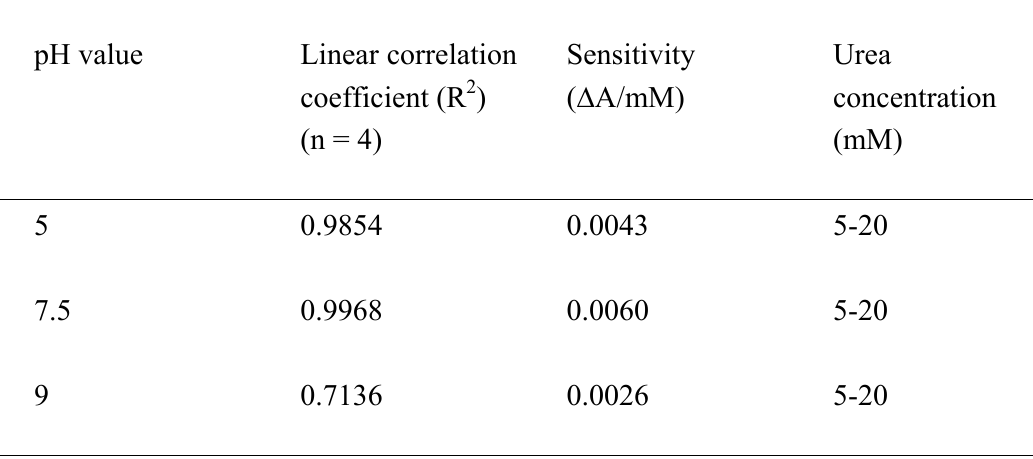
Table 2. The linear correlation coefficients (R 2 ) and the sensitivity of